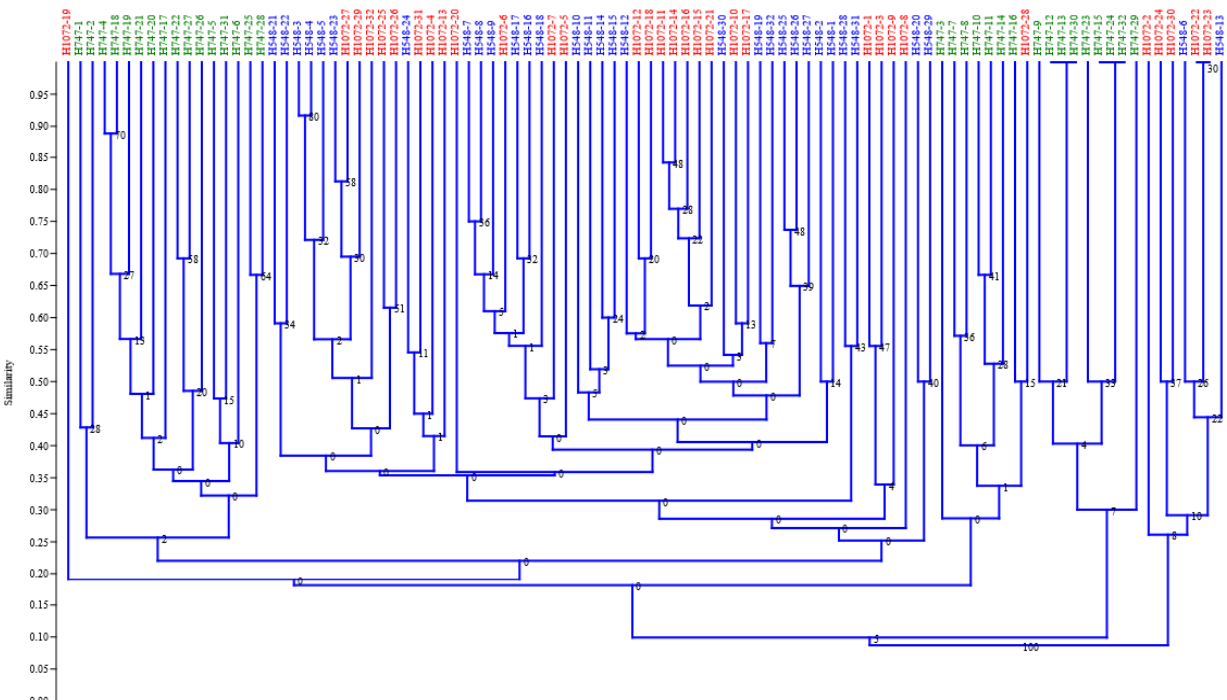
Figure 1. Unweighted pair group method with an arithmetical average UPGMA dendrogram generated by Sequence-related amplified polymorphism SRAP markers, showing the relationships among tomato Hail accessions from Saudi Arabia, based on Jaccard’s coefficient. Numbers at the branches show bootstrap values, computed from 100 replications of the data.